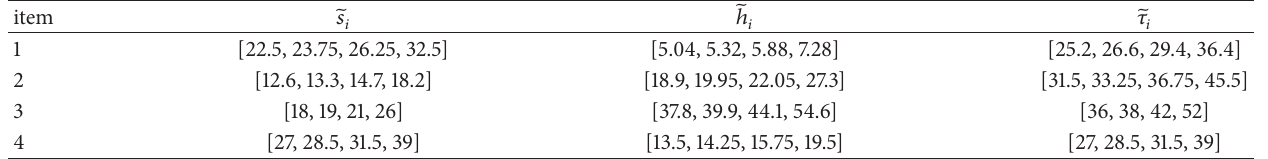
Table 9: The basic data after